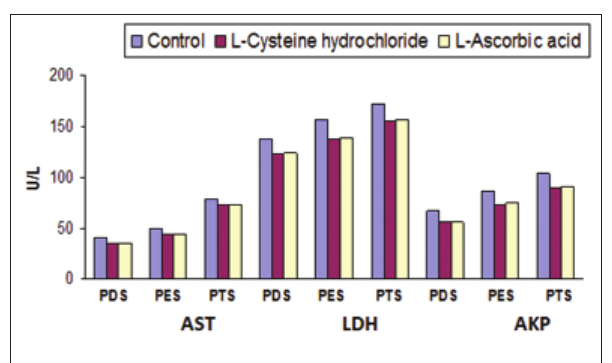
Figure-2: Leakage of aspartate aminotransferase (AST, U/L), lactate dehydrogenase (LDH, U/L) and alkaline phosphatase (AKP, U/L) from bull spermatozoa during different stages of preservation in diluents with and without